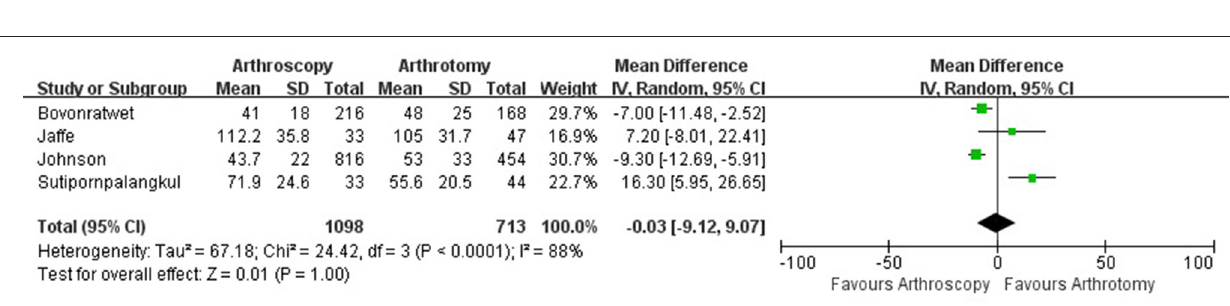
FIGURE 4 | Forest plots of the comparison of arthroscopy and arthrotomy for hospital length of stay.